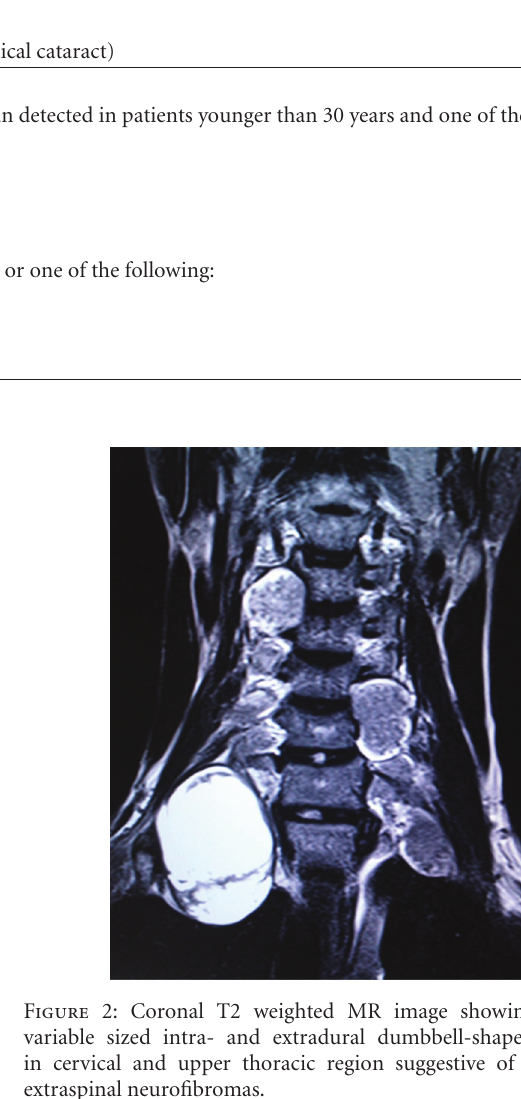
Figure 1: Sagittal T1 postcontrast MR image of the cervical spine showing multiple intramedullary intensely enhancing mass lesions at cervical cord and extramedullary mass lesion at C5 level suggestive of ependymomas/astrocytomas and neurofibroma, respectively.